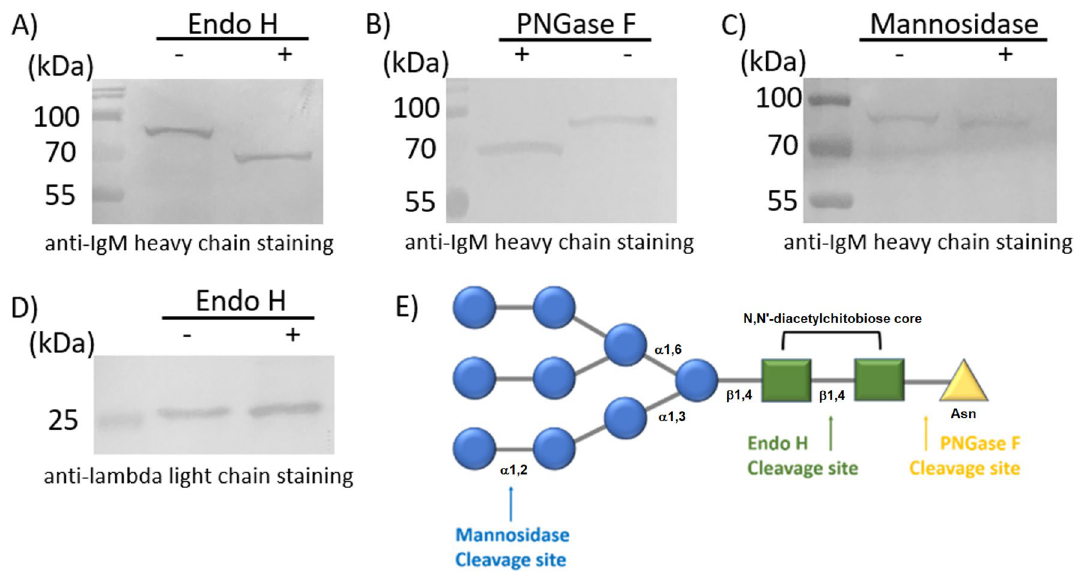
Figure 3. Immunoblotting of glycosidase assay product. Cell lysates from engineered BZ cells were used for glycosidase assays using ( A , D ) EndoH, ( B ) PNGase F, or ( C ) Mannosidase and separated by SDS-PAGE. Immunoblotting of the transfers and staining with ( A – C ) anti-IgM heavy chain (primary) or ( D ) anti-lambda light chain (primary) revealed a shift in the size of the heavy chain resulting from cleavage of the glycan while the light chain size was unchanged. A smaller band shift for cleavage by Mannosidase relative to EndoH or PNGase F is expected based on ( E ) the location of the cleavage